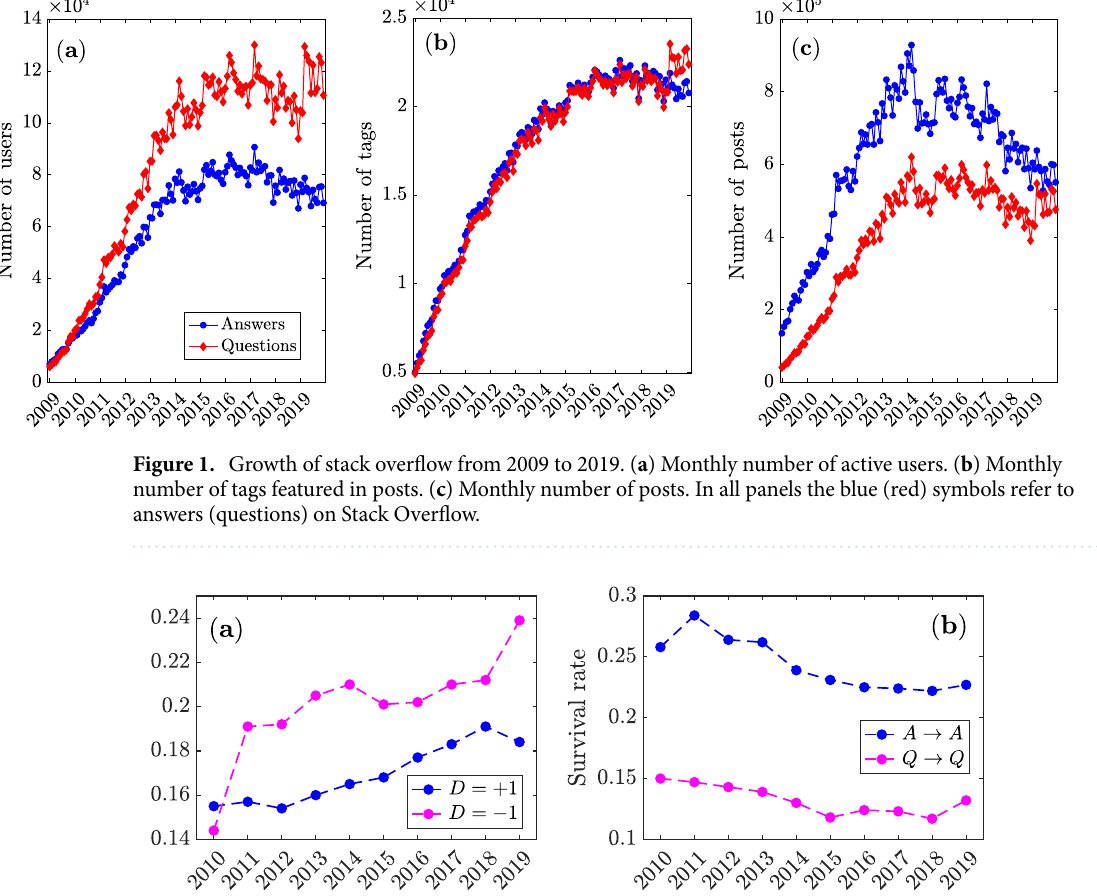
Figure 2 (top left) shows the annual proportions of users who only post answers ( D i = + 1 ) or questions ( D i = − 1 ). Let us label such two groups as A -users and Q -users, respectively. Overall, the proportions of users belonging to both groups grow over time. However, the fraction of A -users remains relatively stable between 15% and 20% (even showing some decline in 2019), whereas the proportion of Q -users increases from less than 15% to almost 25% . After an initial phase where A -users are more numerous, Q -users become the relative majority in 2011, signalling the platform’s transition from a ‘supply-driven’ to a ‘demand-driven’ knowledge marketplace.